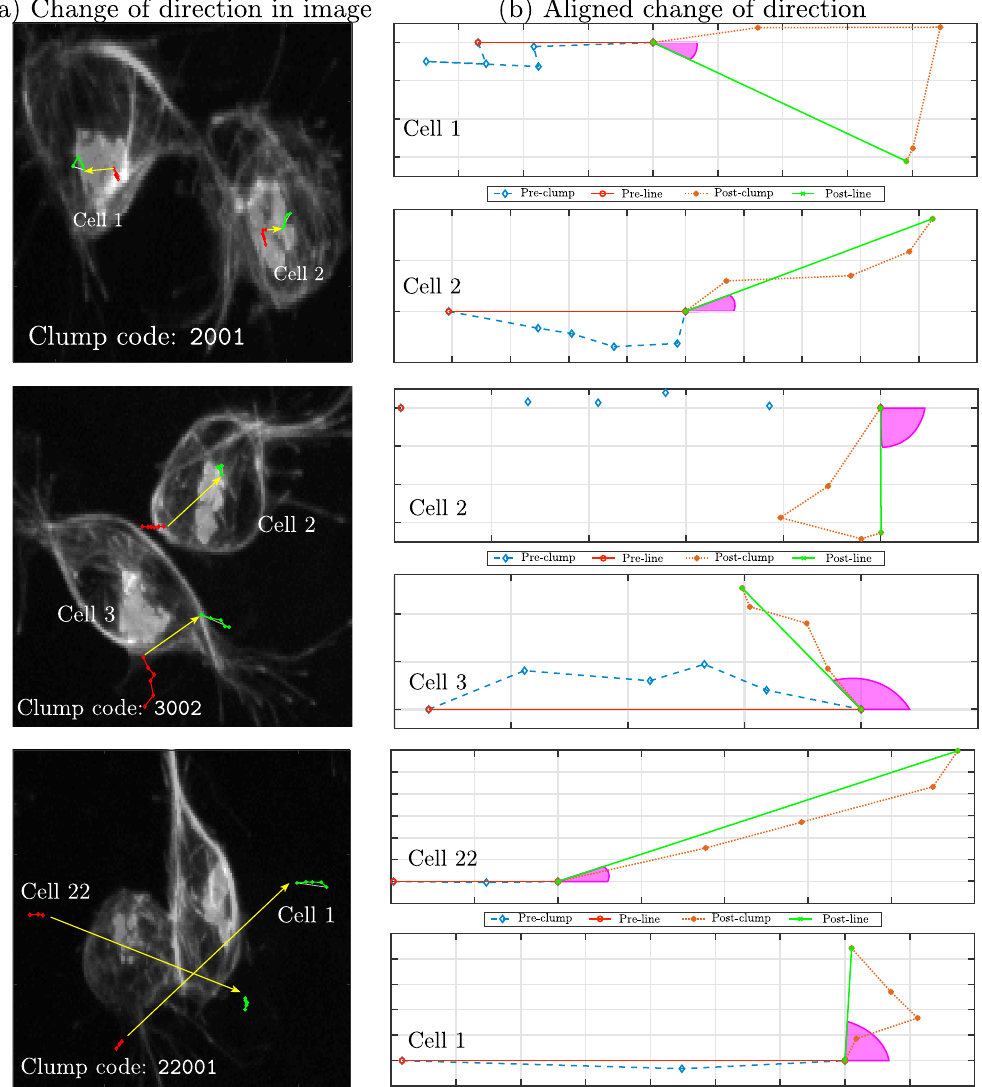
Figure 6. This figure shows three examples of the change of direction before and after a clump. Column ( a ) shows the cells that interact in three different clumps: 2001, 3002 , and 22001 . A red line ( ∗− ) shows the orientation of movement before the clump, and a green line ( (cid:5)− ) represents the positions of movement after. A yellow arrow is superimposed on the image to show the trajectory of the cell inside the clump. ( b ) Simplified view of the cells’ changes in orientation. The cells’ path before the clump